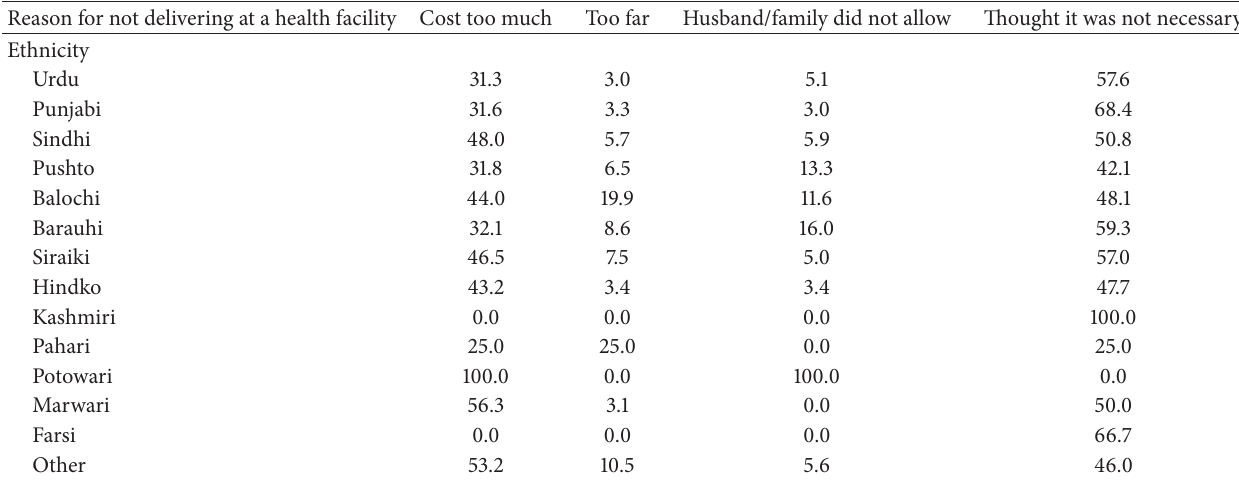
Table 5: Percent of women citing each reason for not delivering at a health facility by ethnicity,